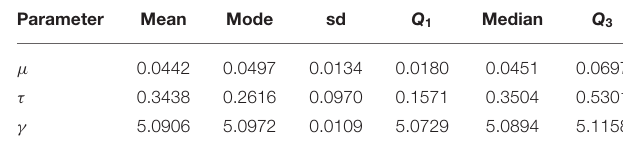
TABLE 3 | Bayes estimates of parameters based on scenario 3 with prior parameters µ 0